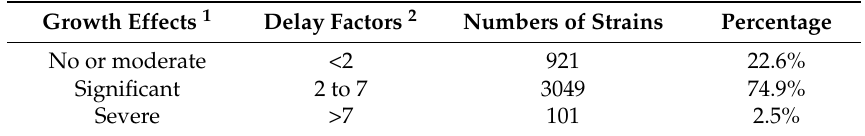
Table 1. The summary of delay factors of individual a complete set of E. coli K-12 ORF archive (ASKA) strains.